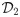
Comparison of the different models on dataset D2.The relative measure of model performance, i.e. the per-bin log-likelihood Δp (see Eq (13)) between any model and the most complex model (MGαβη) are significantly negative (with exception of MGαη, and trivially MGαβη), implying that the added complexity improves the model fit without overfitting. This holds for both validation scores Δp
valid (black) and scores from unseen test data Δp
test (red). Error bars denote one standard error of the mean (S.E.M.). The biggest improvement of fit quality is achieved by including the spike-related kernel (upper vs. lower part of the figure).